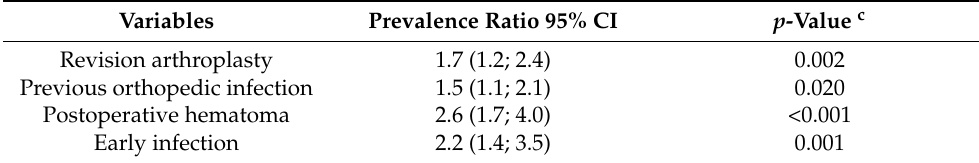
Table 3. Predisposing factors independently associated with MDR-GNB a PJI b in the multivari- ate